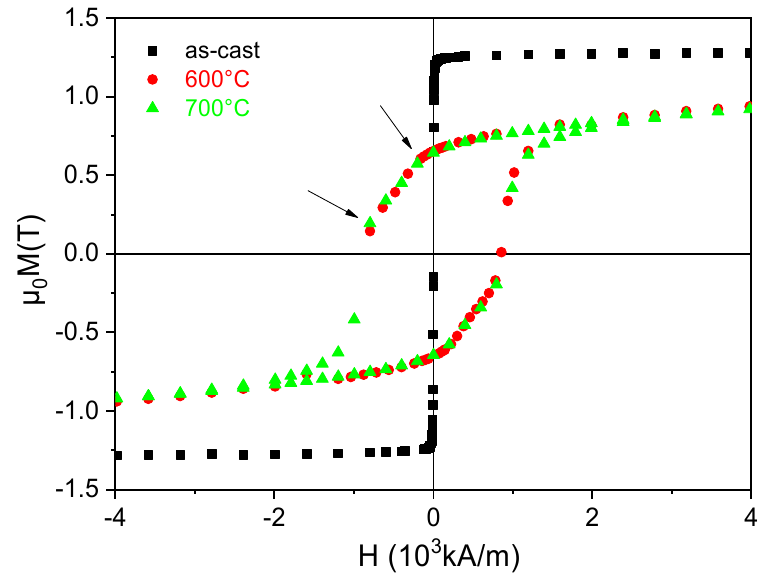
Figure 7. RT hysteresis loops for the as-cast and annealed Figure 7: RT hysteresis loops for the as-cast and annealed samples. Table 4. Magnetic parameters obtained for annealed samples at 300 K in parallel applied field.